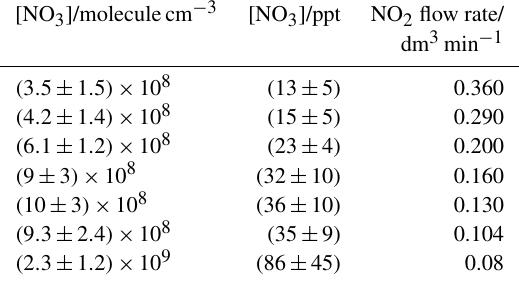
Table 1. The concentrations of NO 3 calculated from IR measure- ments of [NO 2 ] and [N 2 O 5 ] are reported in the first column as molecule cm − 3 and the corresponding ppt value is given in the sec- ond column; in the third column the flow rate of NO 2 is shown (the total gas mixture flow rate is obtained by adding the constant O 2 flow rate of 1.2dm 3 min − 1 to these